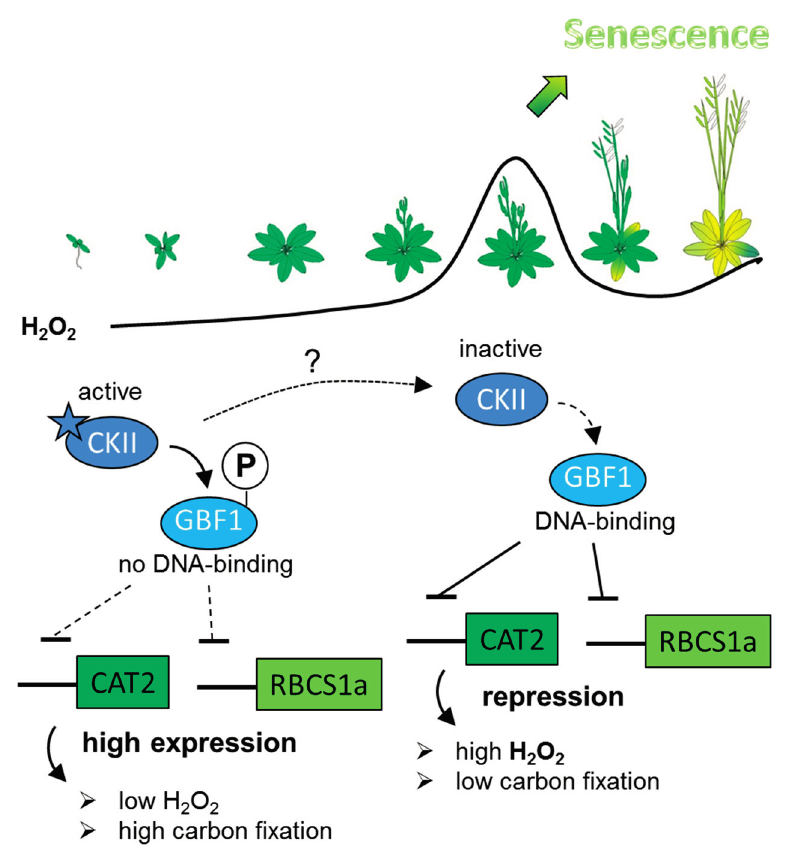
Figure 5. Model of senescence-specific activation of GBF1 by CKII